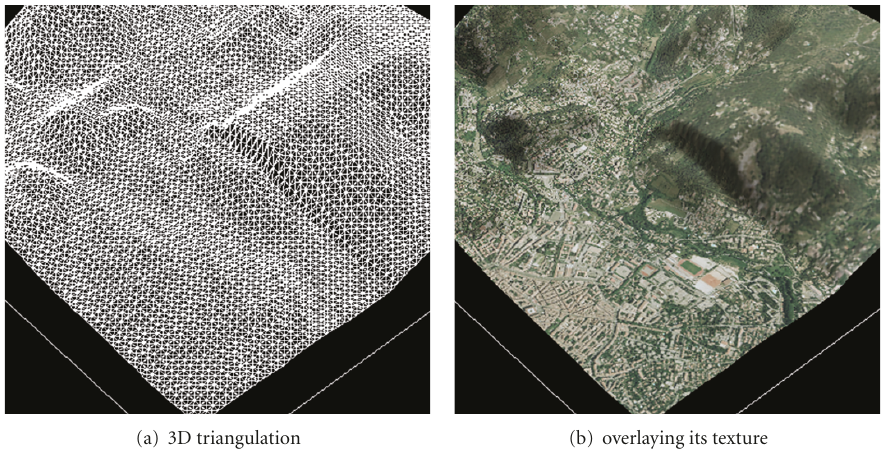
Figure 20: 3D views after tessellation without smoothing ( l h = 0, l m = 2, l l = 3).